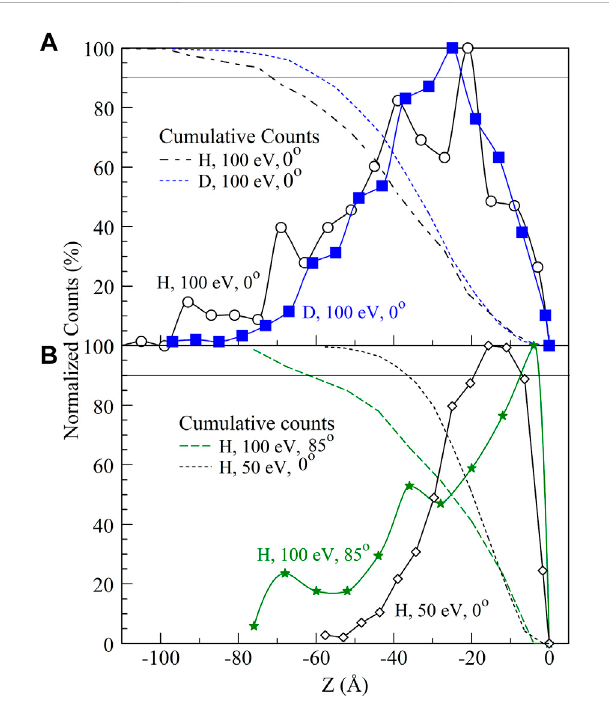
FIGURE 12 Distributions of impacting H and D atoms retained in a:LiH and a: LiD targets at 300 K (solid lines with symbols), respectively, and normalizedcumulativecounts(in%)oftheretainedatoms(dashedlines). All distributions are scaled to its maximum value for each incident data.